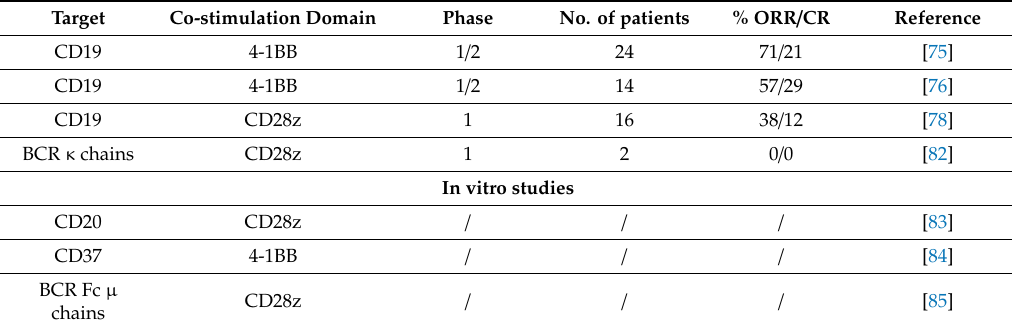
Table 4. Overview of chimeric antigen receptor (CAR) constructs tested in CLL and discussed in this review. CR—complete